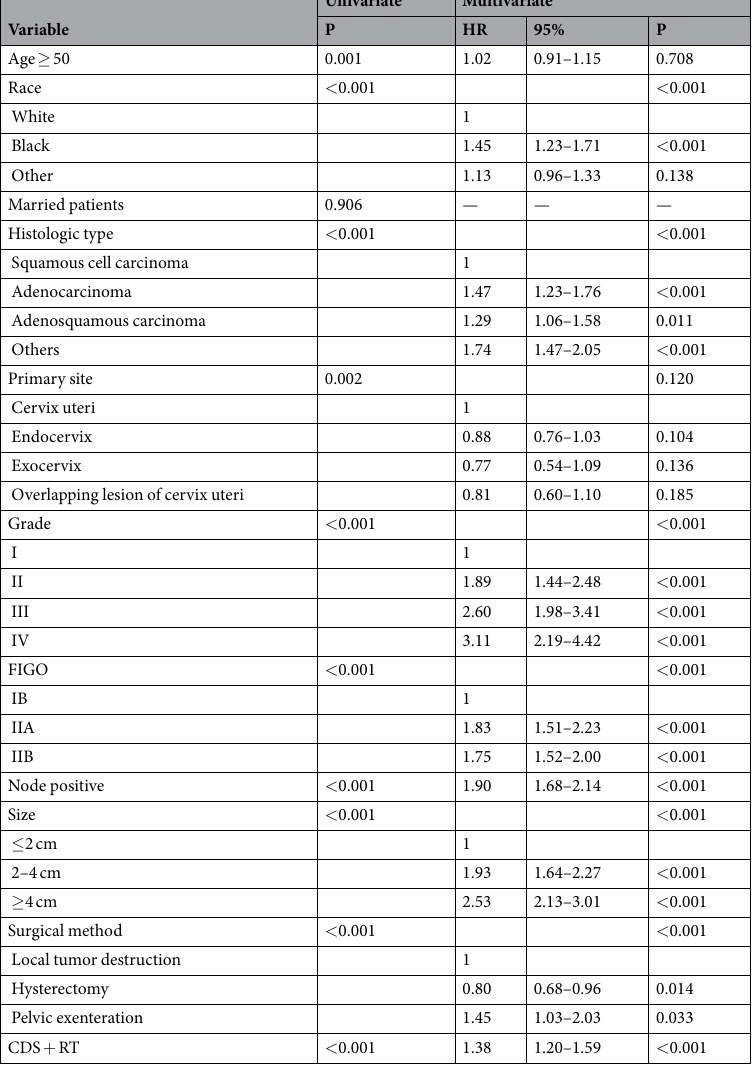
Table 2. Univariate and multivariate analysis of cause-specific survival. HR = hazard ratio; CI = confidence interval; FIGO: International Federation of Gynecology and Obstetrics; CDS: cancer-directed surgery; RT: